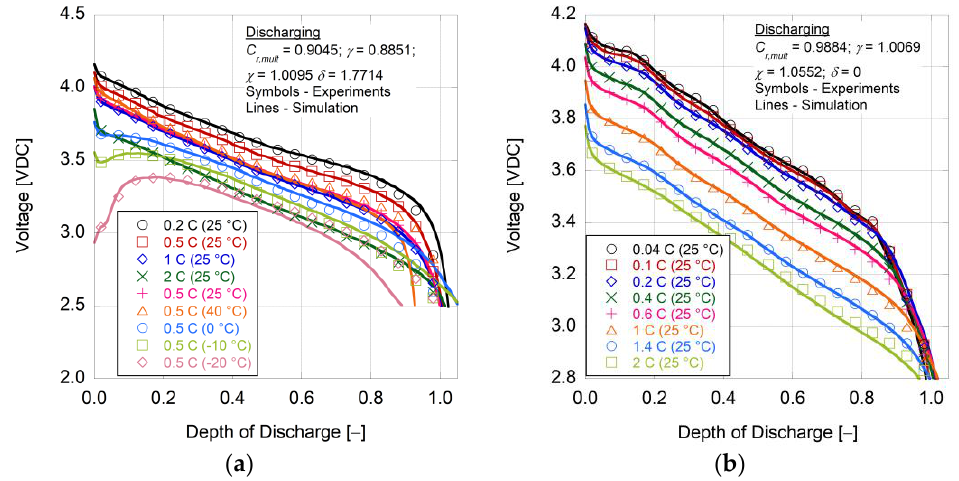
Figure 6. Experimental data and model results of representative NCA batteries during discharging with ( a ) indicated as NCA 1 and ( b ) as NCA 2 .